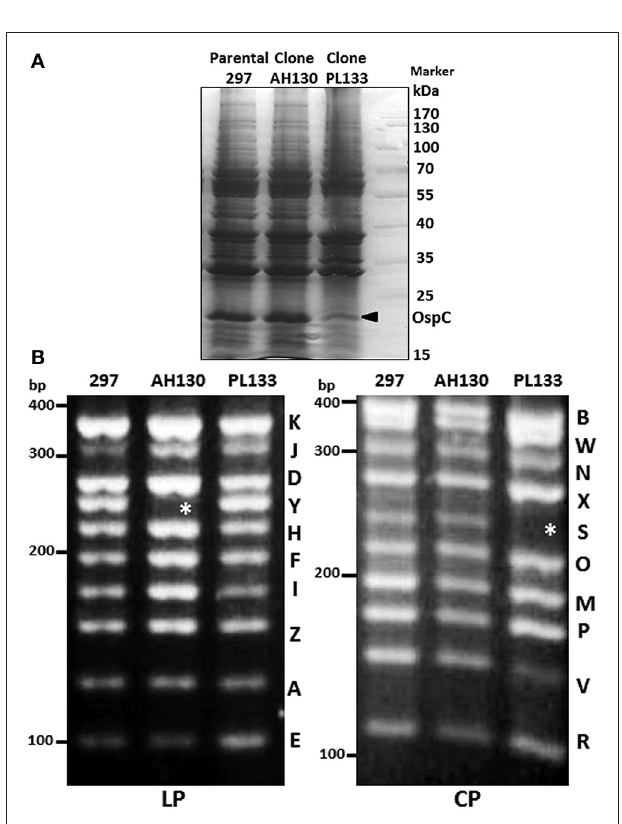
FIGURE 2 | Protein profile and plasmid content of B. burgdorferi strain 297 clones AH130 and PL133. (A) SDS-PAGE gel. B. burgdorferi strain 297 clones AH130 and PL133 were cultivated at 37 ◦ C and harvested at stationary phase of growth. The band corresponding to OspC is indicated by arrow. (B) Plasmid content of linear plasmid (LP) and circular plasmid (CP). Asterisk (*) indicates absent plasmids.